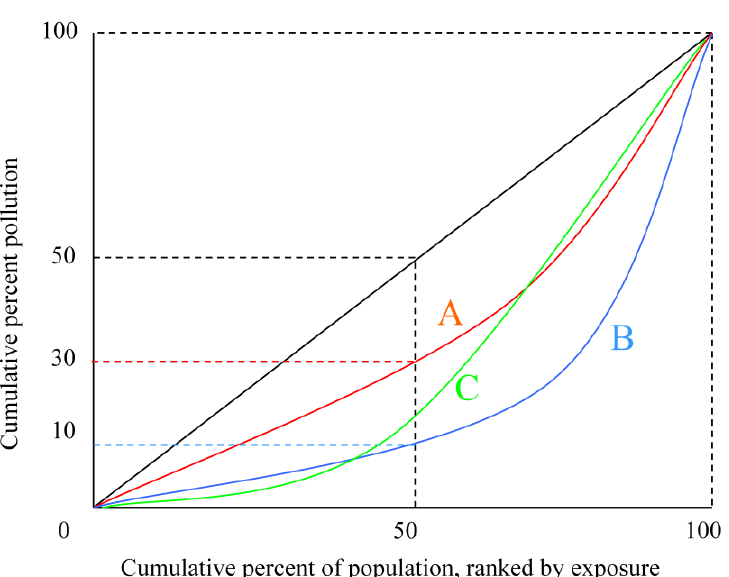
Figure 1. Lorenz